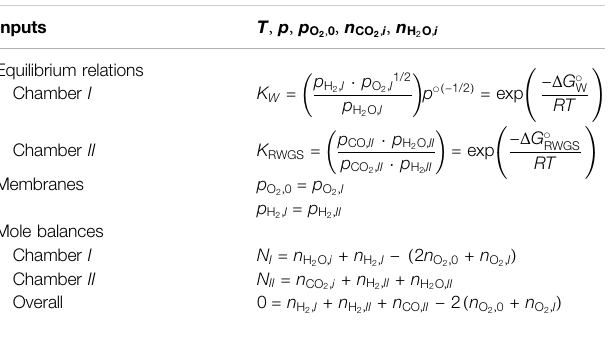
TABLE 1 | System of equations for the dual-membrane reactor.